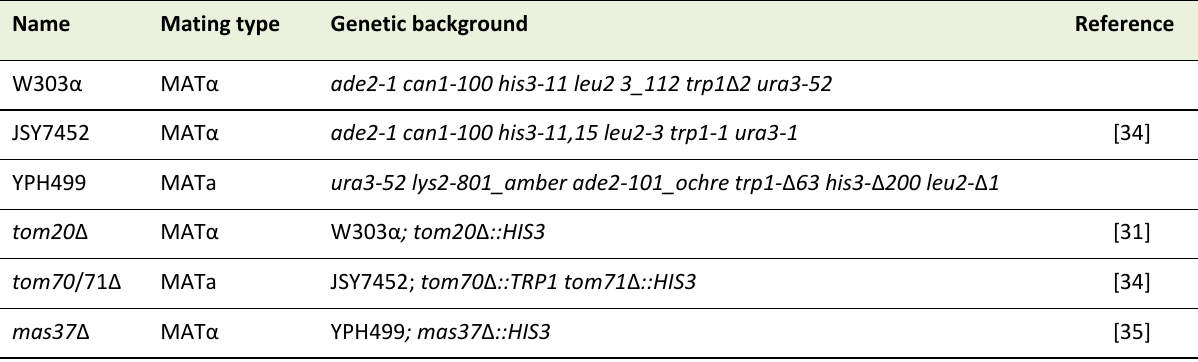
TABLE 1: List of yeast strains used in this study.